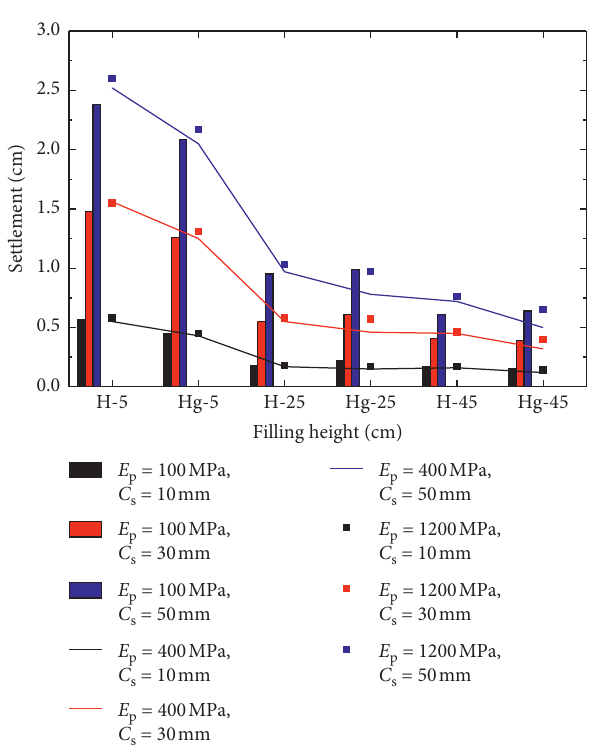
Figure 16: Variation of the settlement with different consolidation settlements.